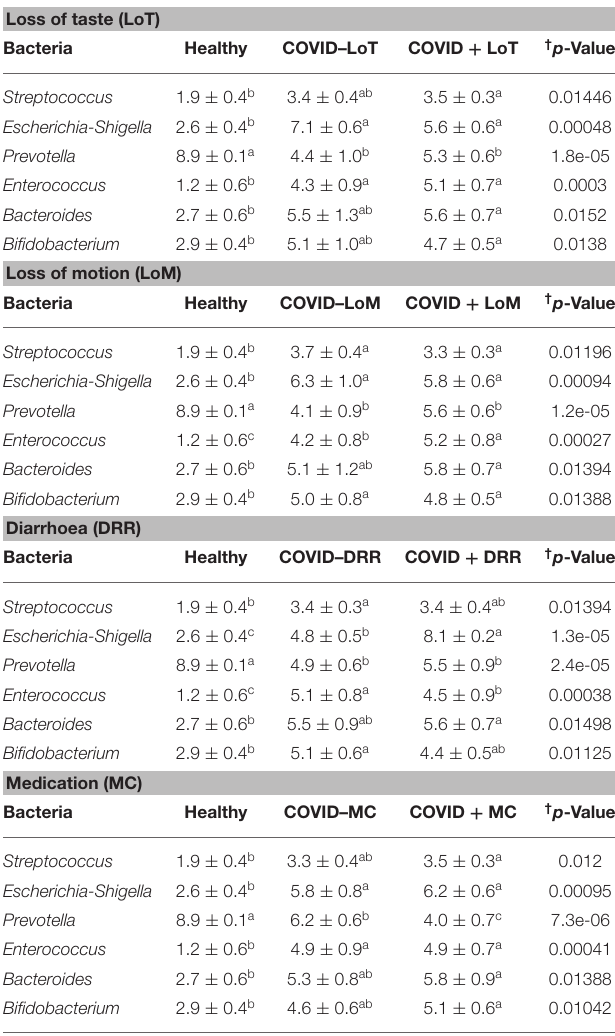
TABLE 2 | Major genera in the oral wash of patients with COVID-19 and healthy controls in response to various clinical conditions.